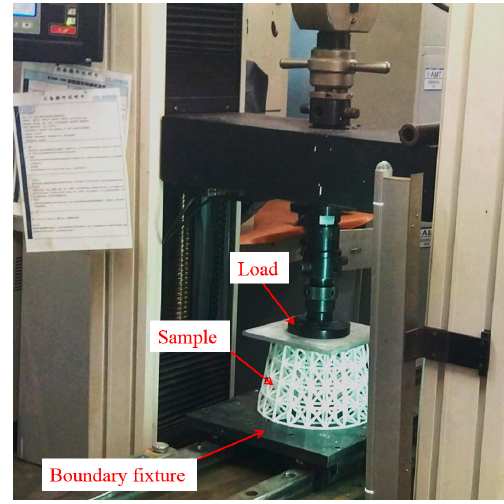
Figure 24. Experimental setup.